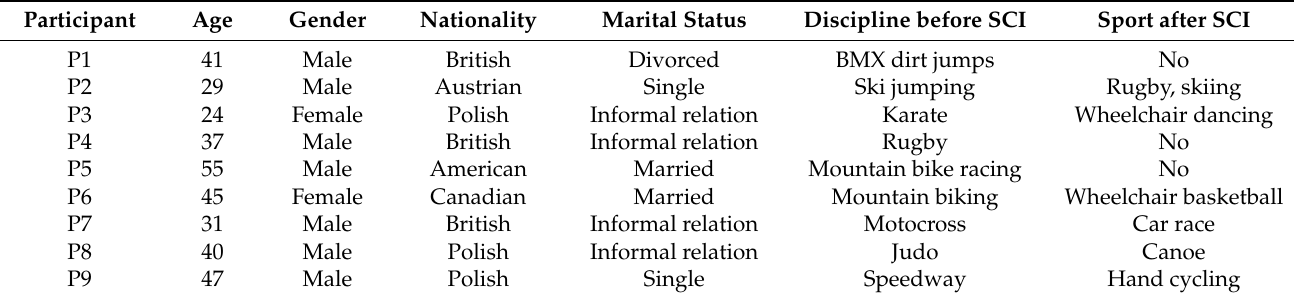
Table 1. Sociodemographic data of study participants.